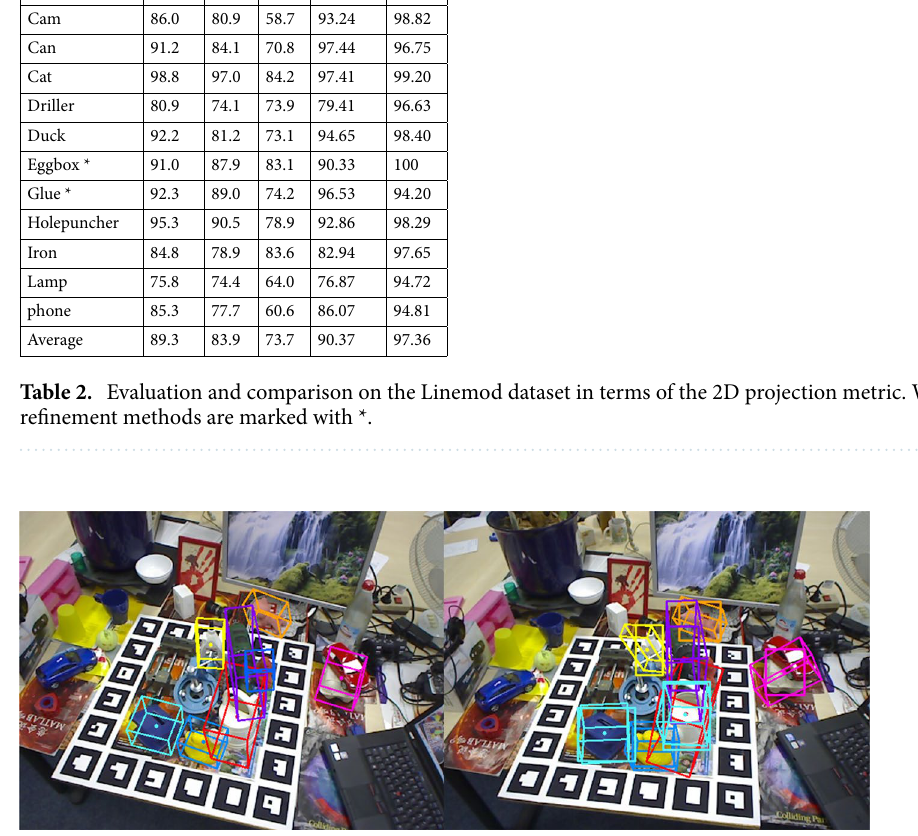
Figure 4. Multi-object(8 objects) detection map (the left picture is 6D pose results, the right picture not only has 6D but also has 2D detection results).